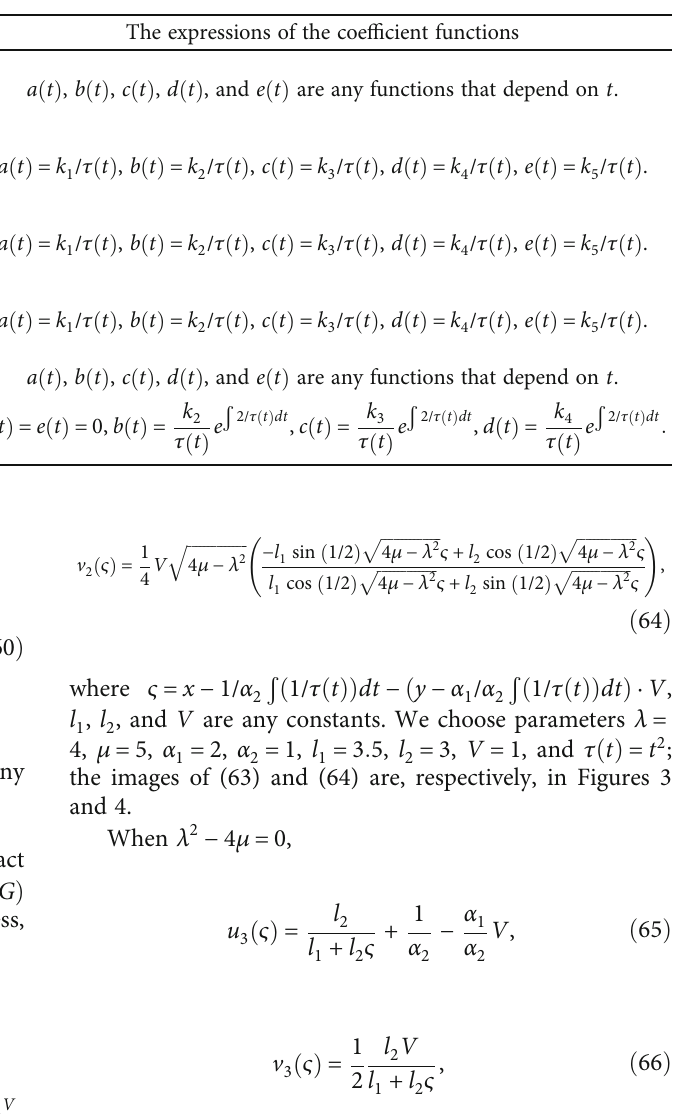
Table 4: The expressions of the coe ffi cient